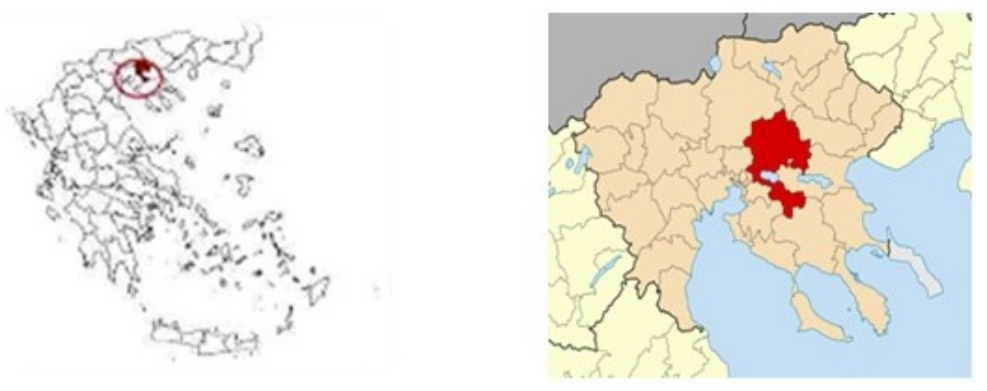
Figure 1. The Municipality of Lagkadas (Study area)